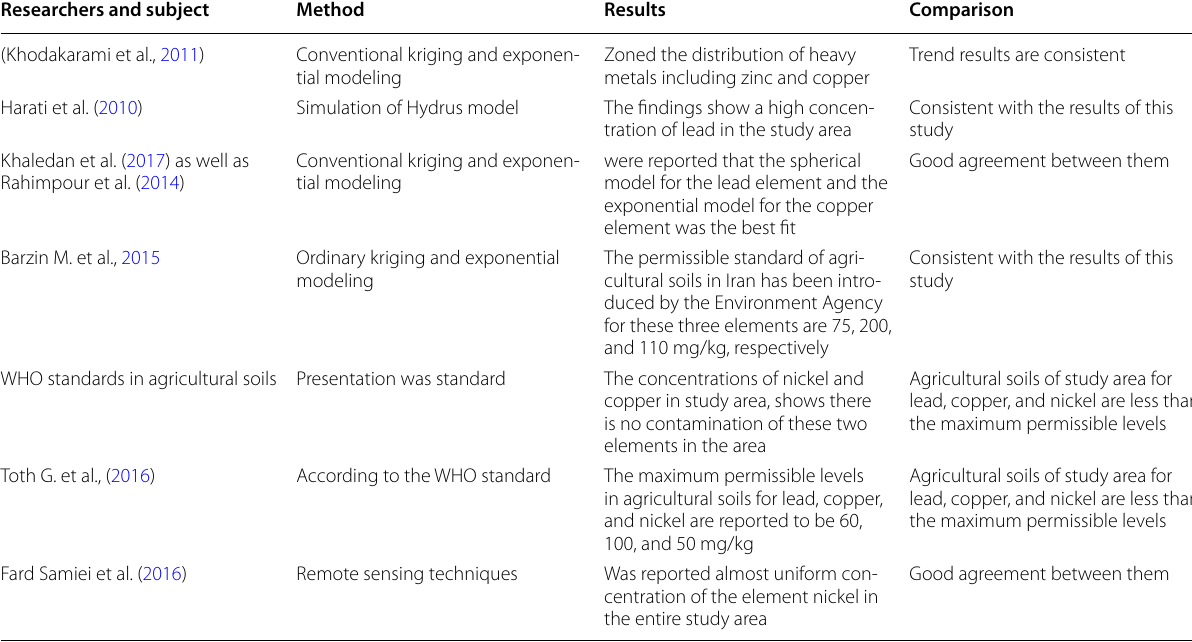
Table 7 Comparison of the verification results of this research with previous